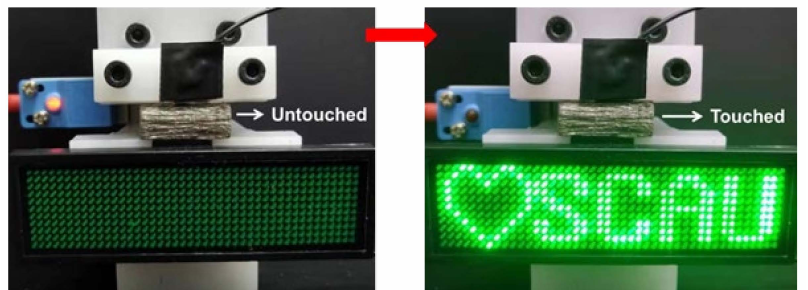
Figure 9. Digital images of the electronic circuit. The as-made Ni-PW was used as electrical substrate for powering a display with the letters “S C A U”.